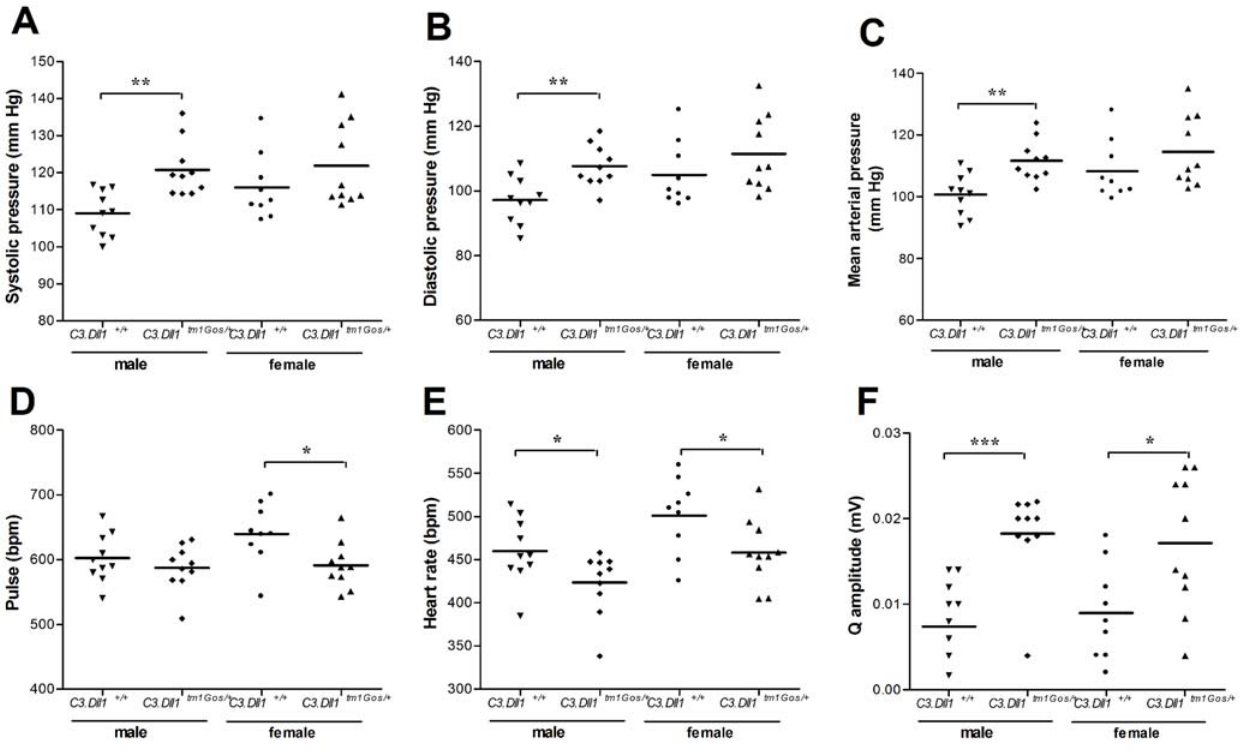
Figure 3. Selected blood pressure and electrocardiogram parameters in heterozygous C3.Dll1 tm1Gos/ + animals and their wild-type littermates. A–F) Depicted are the scatter dot plot representations and the mean for each group: heterozygous C3.Dll1 tm1Gos/ + males (n=10) and their wild-type littermates ( C3.Dll1 + / + , n=10); heterozygous C3.Dll1 tm1Gos/ + females (n=10) and their wild-type littermates ( C3.Dll1 + / + , n=9). P -value calculated performing unpaired t-test as variances were not significantly different. P -value: * P , 0.05, ** P , 0.01, *** P ,